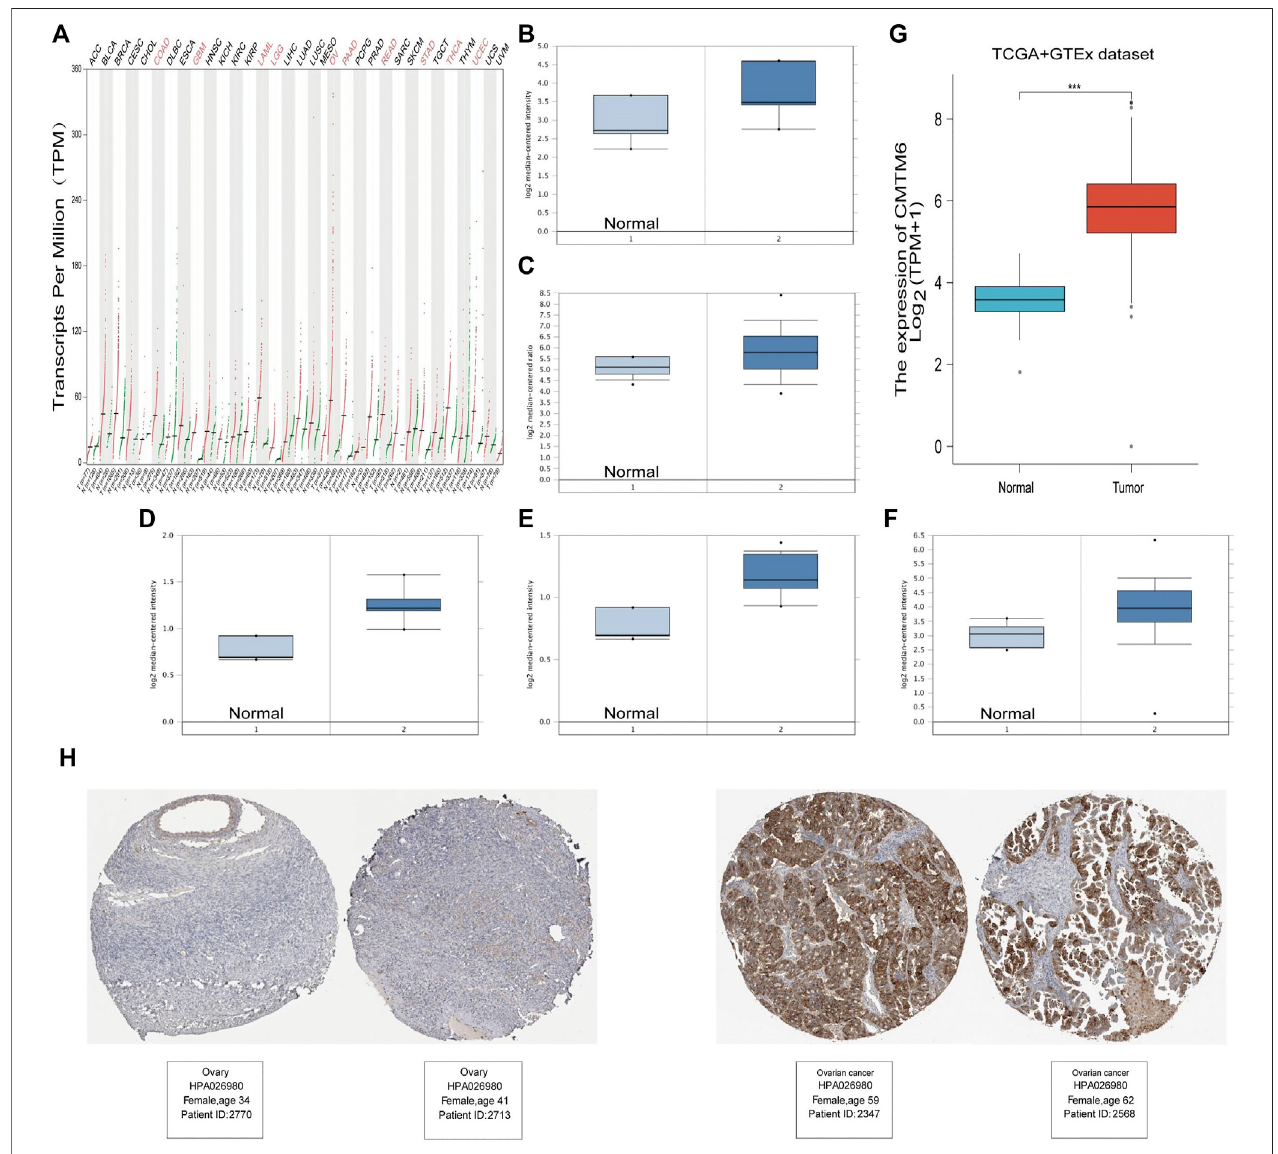
FIGURE 1 | High expression of CMTM6 in various cancers and OV. (A) mRNA level of CMTM6 in human cancer tissues and corresponding normal tissues from GEPIA2. The expression of CMTM6 in the OV samples derived from the Oncomine database. Data shown for (B) ovarian endometrioid adenocarcinoma, (C) ovarian serous adenocarcinoma, (D) ovarian clear cell adenocarcinoma, (E) ovarian mucinous adenocarcinoma, and (F) ovarian carcinoma. (G) CMTM6 expression in OV matched TCGA and GTEx data. (H) Representative immunohistochemistry images and detailed information on the expression of CMTM6 in OV tissues and non- tumor tissues based on the THPA database. *** P < 0.001.